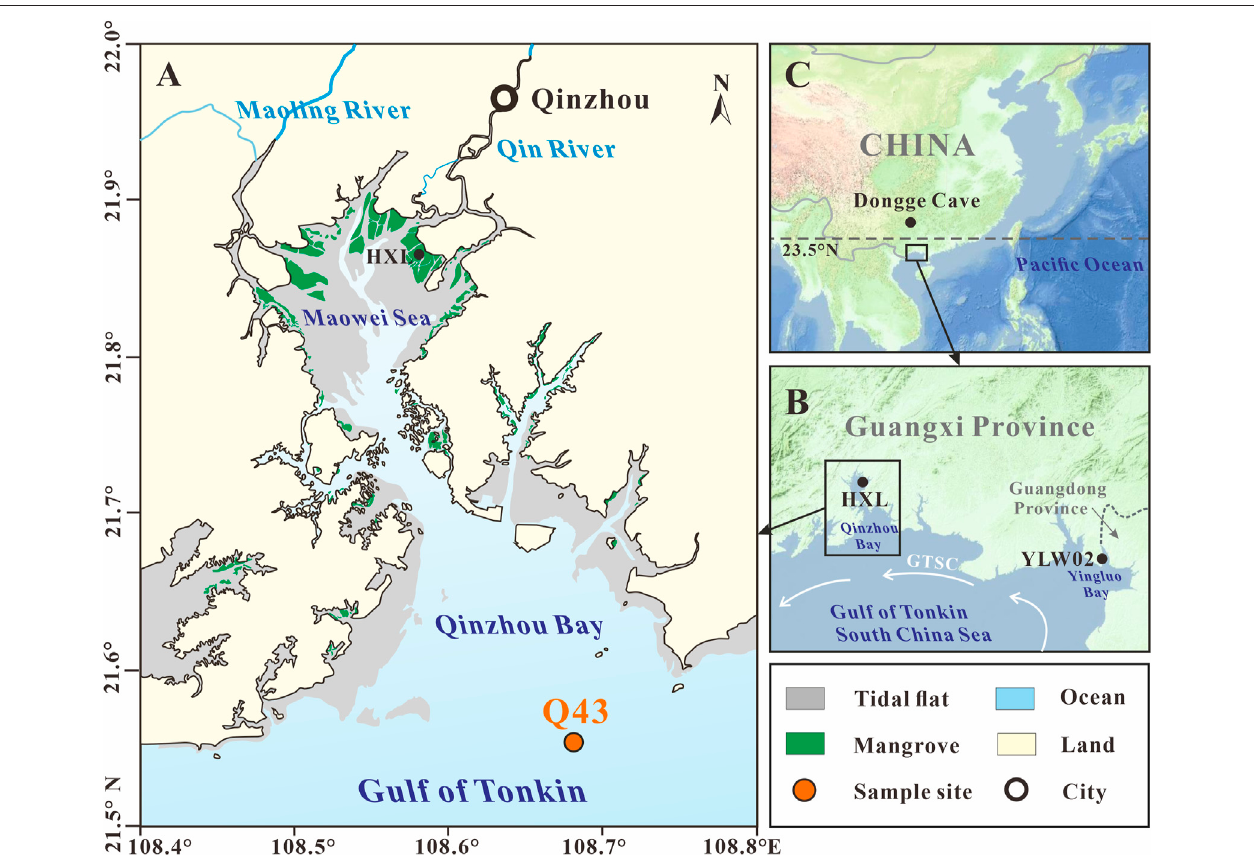
FIGURE1| Locationsofthe (A) sedimentcoreQ43inQinzhouBay, (B) northernGulfofTonkin, (C) tropicalChina.ThereferencedsitescontainHXLinQinzhouBay (Xia et al., 2019), YLW02 in Yingluo Bay (Meng et al., 2017), and Dongge Cave in SW China (Wang et al., 2005). GTSC: Gulf of Tonkin Surface Current (Liu et al., 2016).